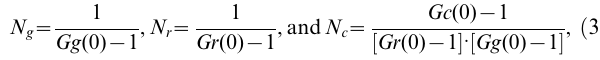
Figure S1 The quantitative evaluation of FCCS data for interaction between different or identical CREB1